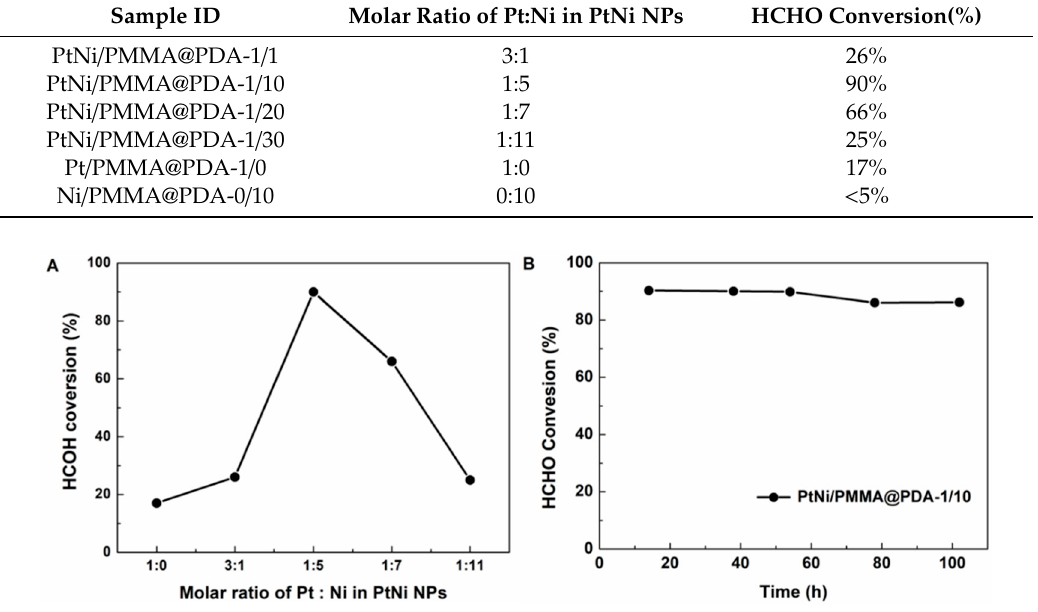
Figure 5. HCHO conversion over various PtNi/PMMA@PDA fibrous membranes with 0.02 dosage at 25 °C as a function of the molar ratio of Pt:Ni in PtNi NPs ( A ); HCHO conversion over PtNi/PMMA@PDA-1/10 as a function of time-on-stream (reactant gas: 10 ppm HCHO, O 2 20 vol %, GHSV 24 000 h − 1 ) ( B ).